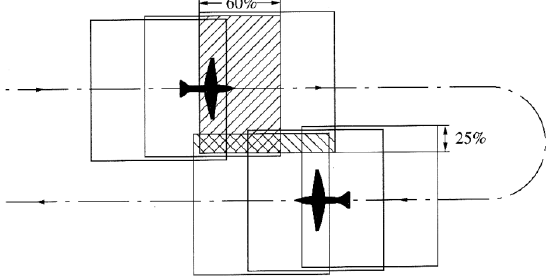
Figure 1. Aerial photography (view from above) and overlap is shown in striped (source : http://www.seos-project.eu)